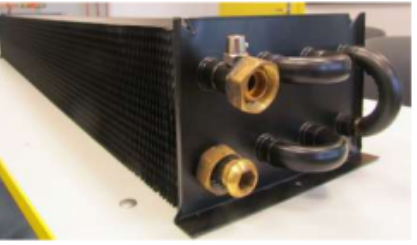
Figure 27. Convector Radiator -8 RS , 8 tubes in series connection.